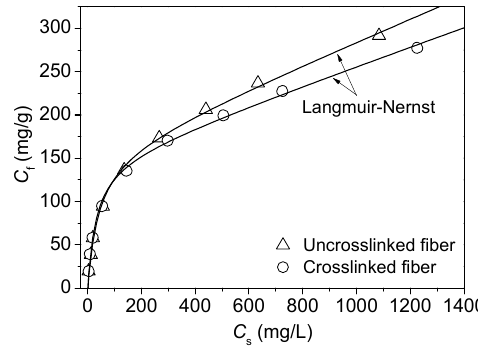
Figure 4. Adsorption isotherms of lac dye on the uncrosslinked and crosslinked chitosan fibers.